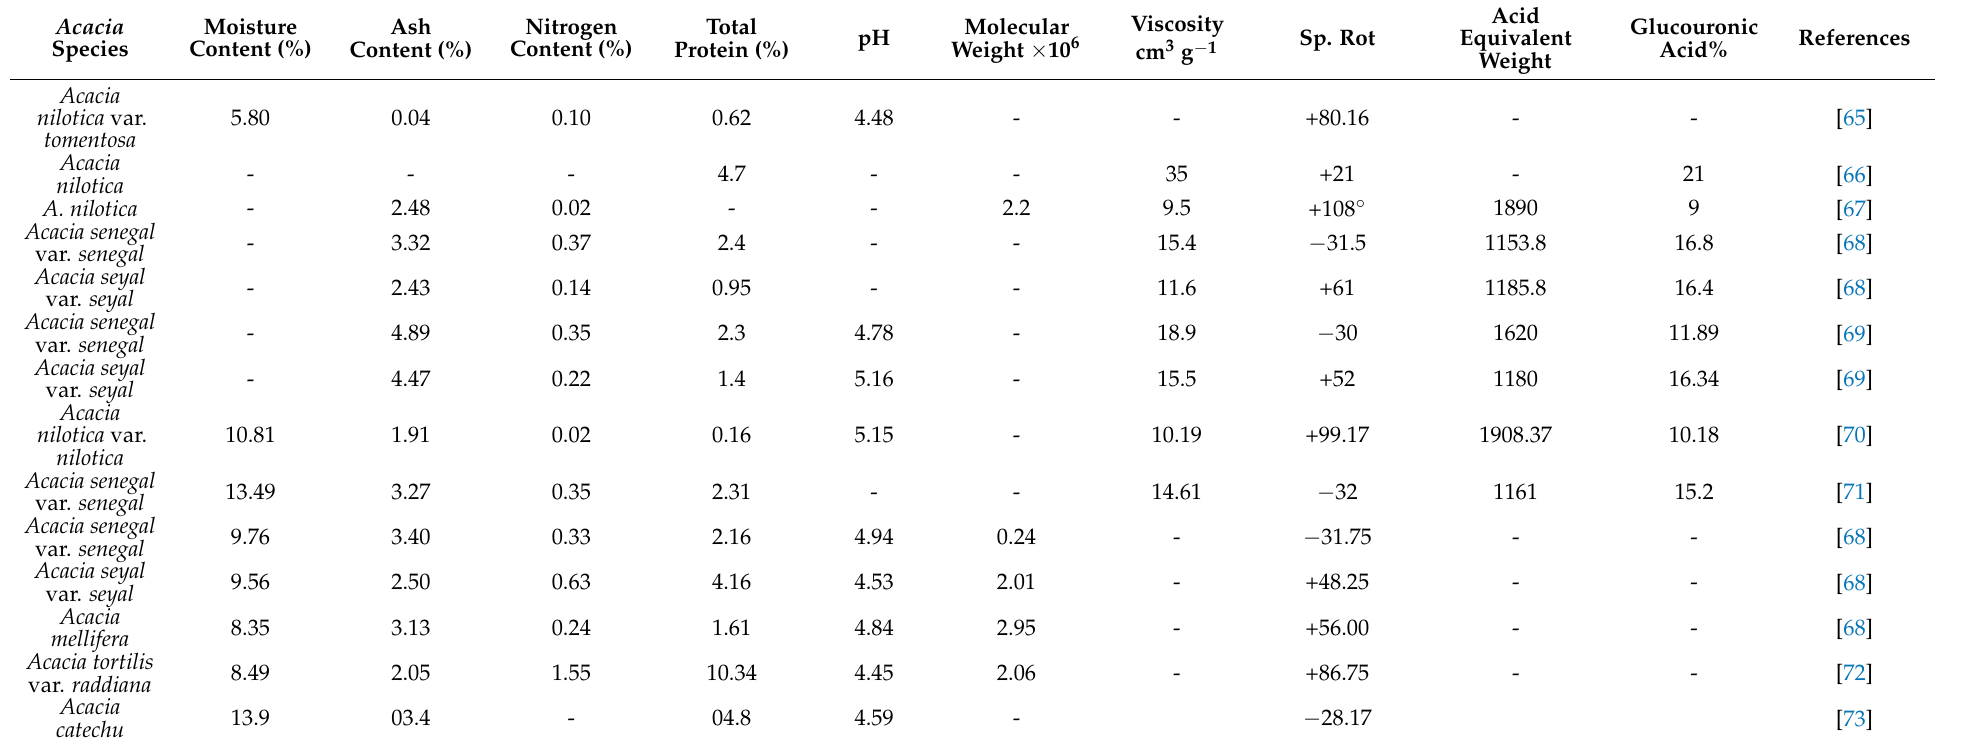
Table 2. Analytical data of the gum exudates from Acacia